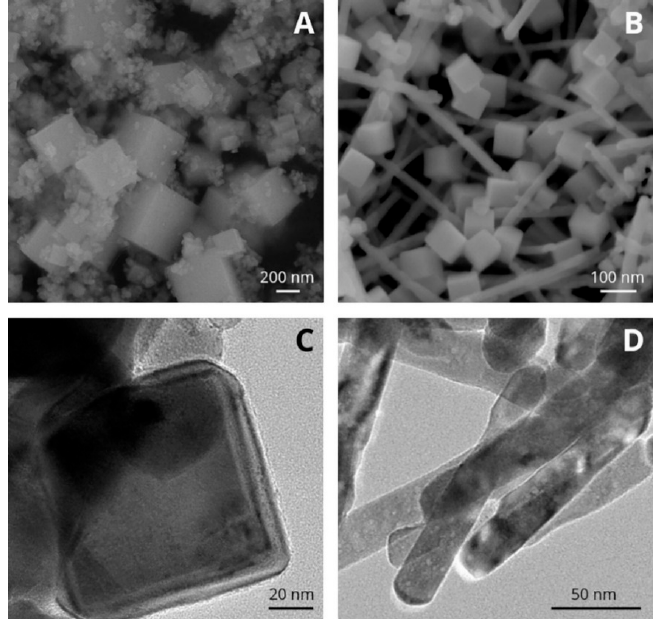
Figure 13. FE-SEM and TEM images of CeO 2 ( A , C ) and 50% Pr-CeO 2 ( B , D ) [107]. Reprinted from Andana, T.; Piumetti, M.; Bensaid, S.; Veyre, L.; Thieuleux, C.; Russo, N.; Fino, D.; Quadrelli, E.A.; Pirone, R. Nanostructured equimolar ceria-praseodymia for NO x -assisted soot oxidation: Insight into Pr dominance over Pt nanoparticles and metal–support interaction. Appl. Catal. B Environ. 2018 , 226 , 147–161, with permission from